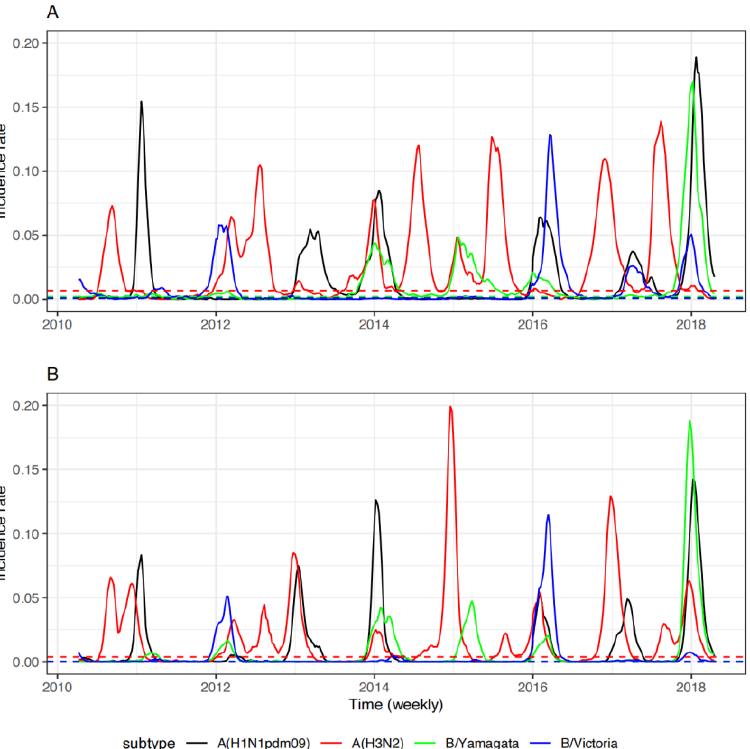
Figure 1. Weekly incidence rate for four seasonal influenza strains in southern China ( A ) and northern China ( B ). Horizontal dash line is the baseline for each strain (see Methods for more details).